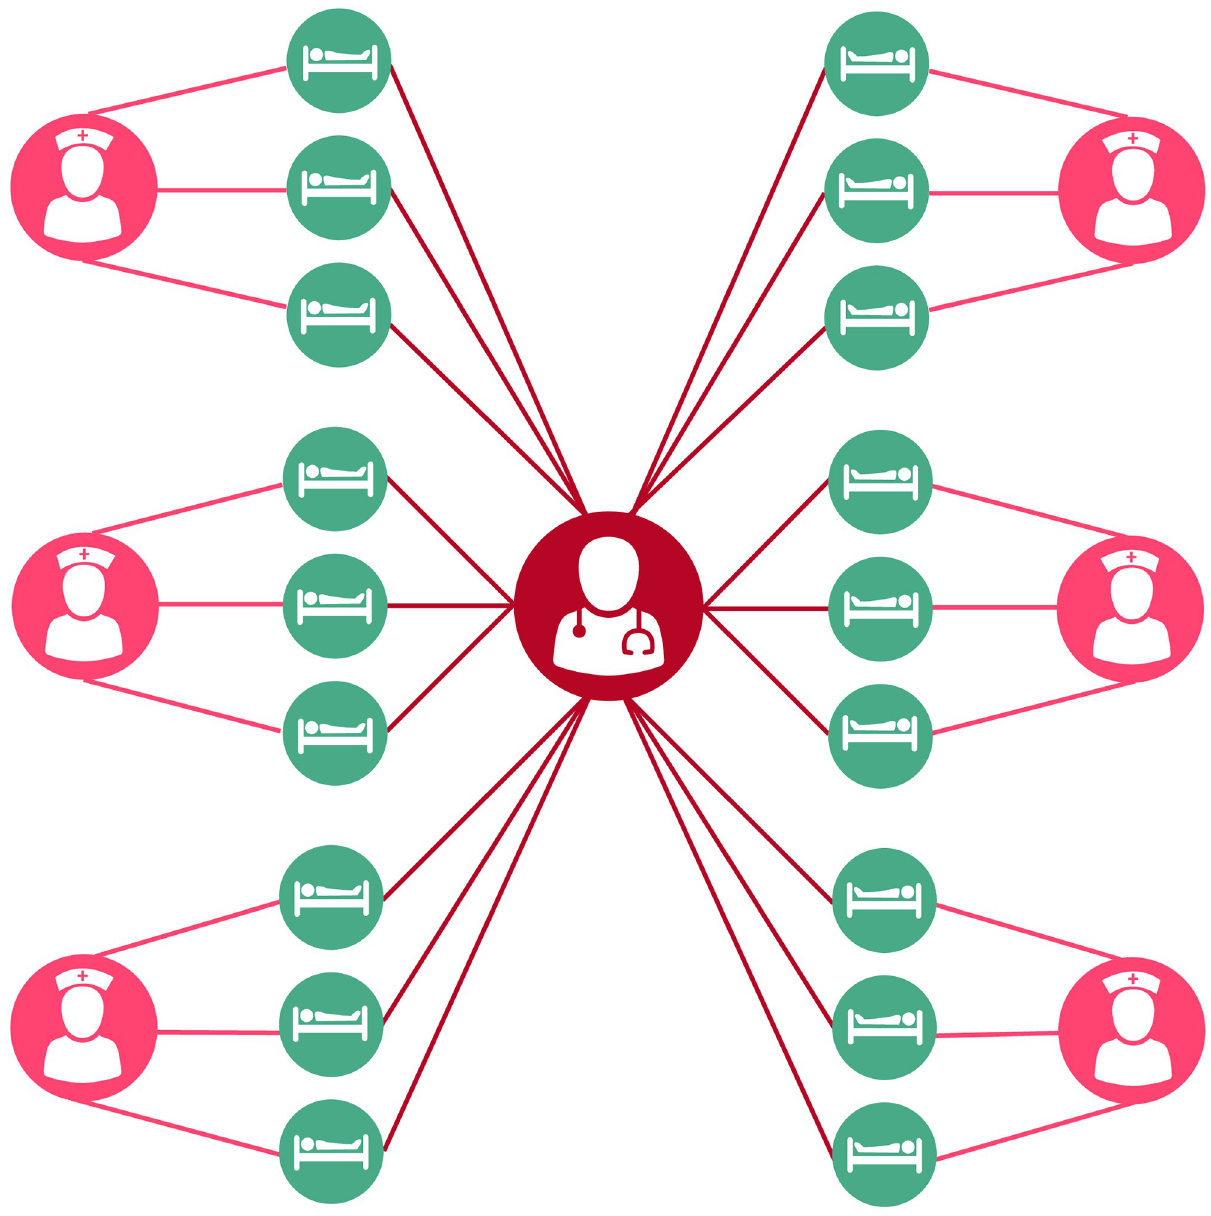
Fig 2. Schematic representation of a meta-population model of methicillin-resistant Staphylococcus aureus (MRSA) acquisition. Patients (blue) are treated by a single assigned nurse (orange). A single intensivist (red) randomly treats all patients. Figure by Eric Lofgren is licensed under CC BY